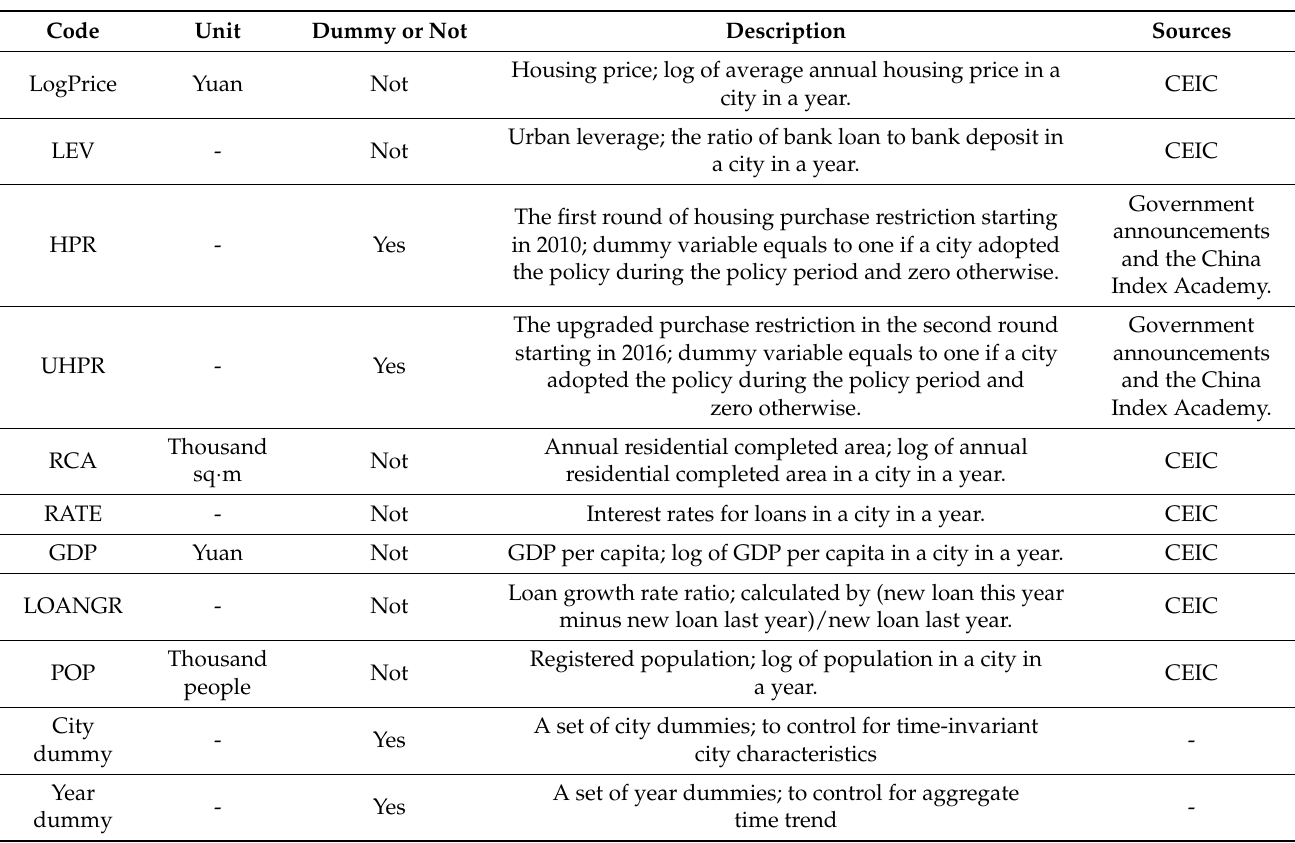
Table 1. Variable definitions and data sources.